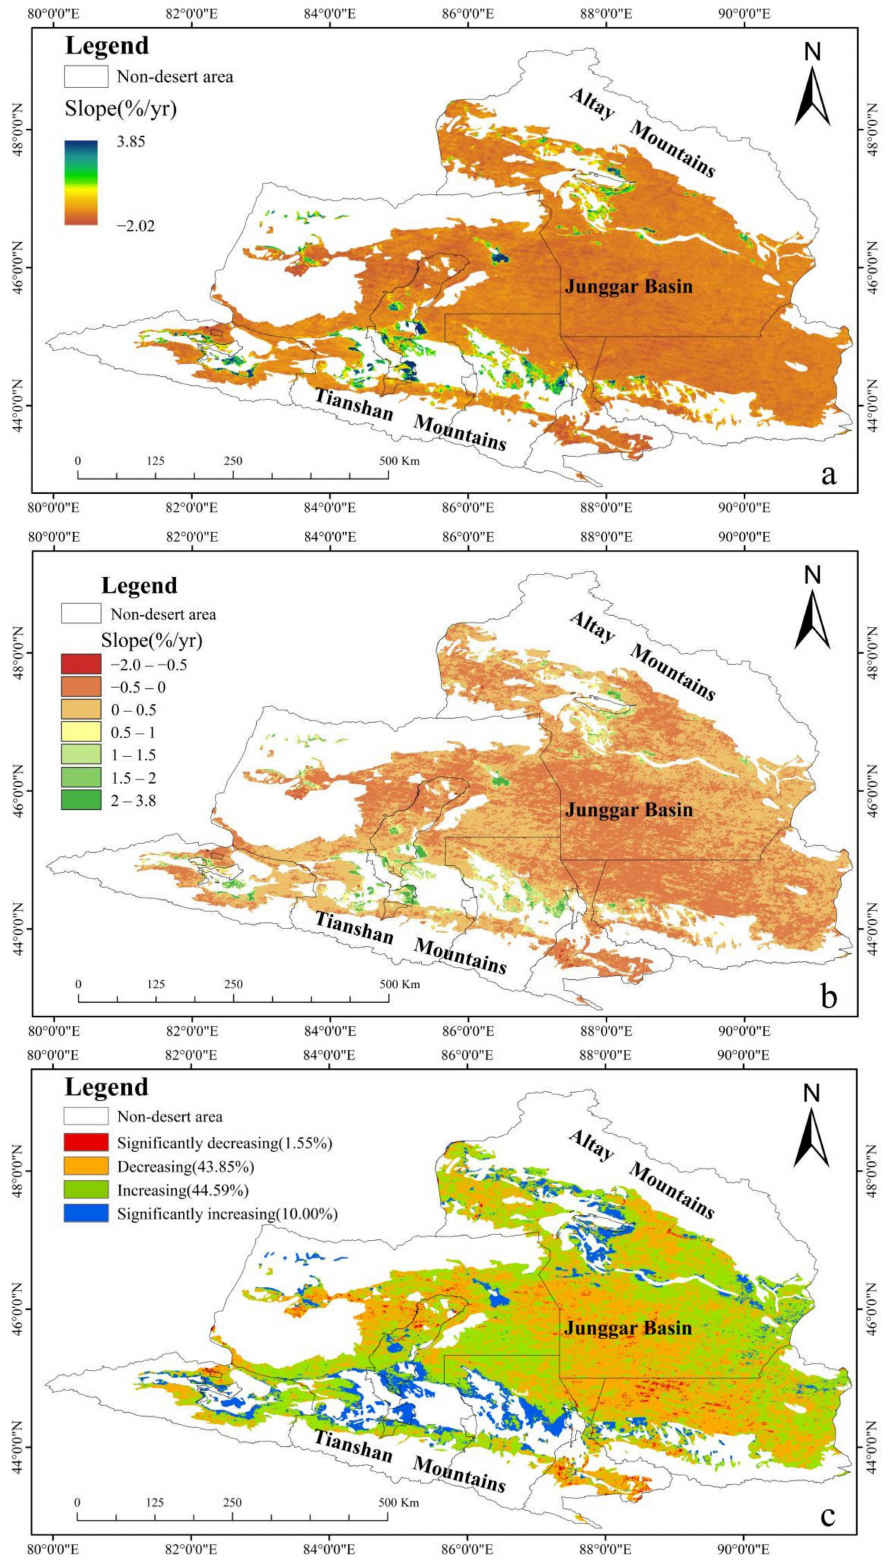
Figure 5. The trend of the yearly maximum vegetation coverage ( a ), spatial distribution of the change trend ( b ), and the corresponding classification results ( c ) in the Junggar Basin from 2001 to 2021. From 2000 to 2021, the variation of average temperature and accumulated precipitation in the desert area of Junggar Basin was little. The average temperature in the